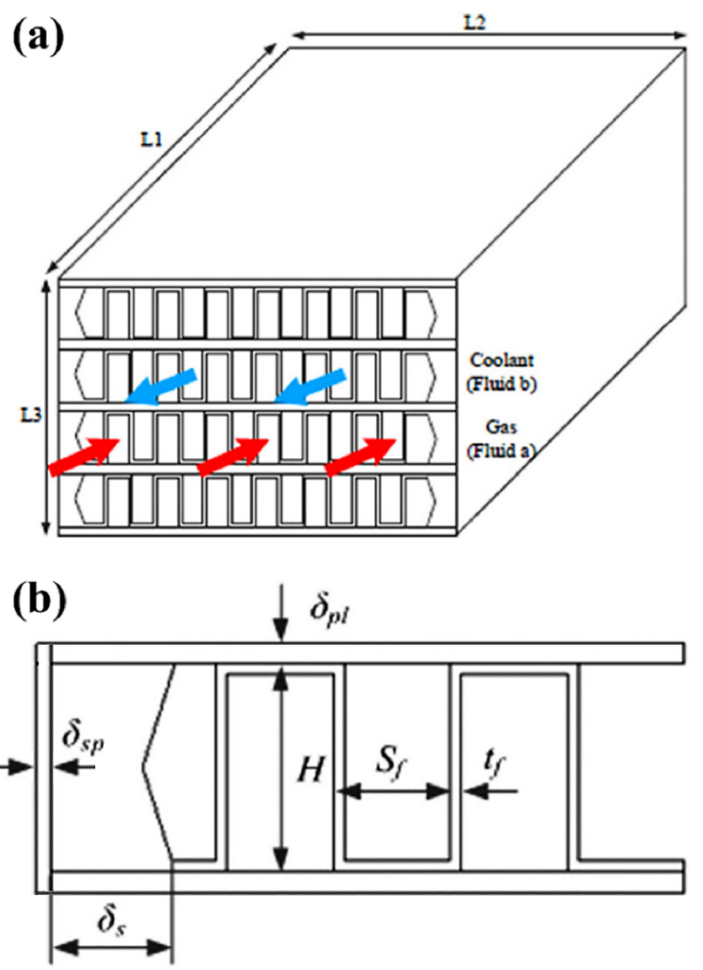
Figure 2. Illustration of the modelled intercooling system, where ( a ) shows the schematic arrangement of the HE, and ( b ) demonstrates the details of the straight fins. Table 1. Constructional data of the modelled intercooler.